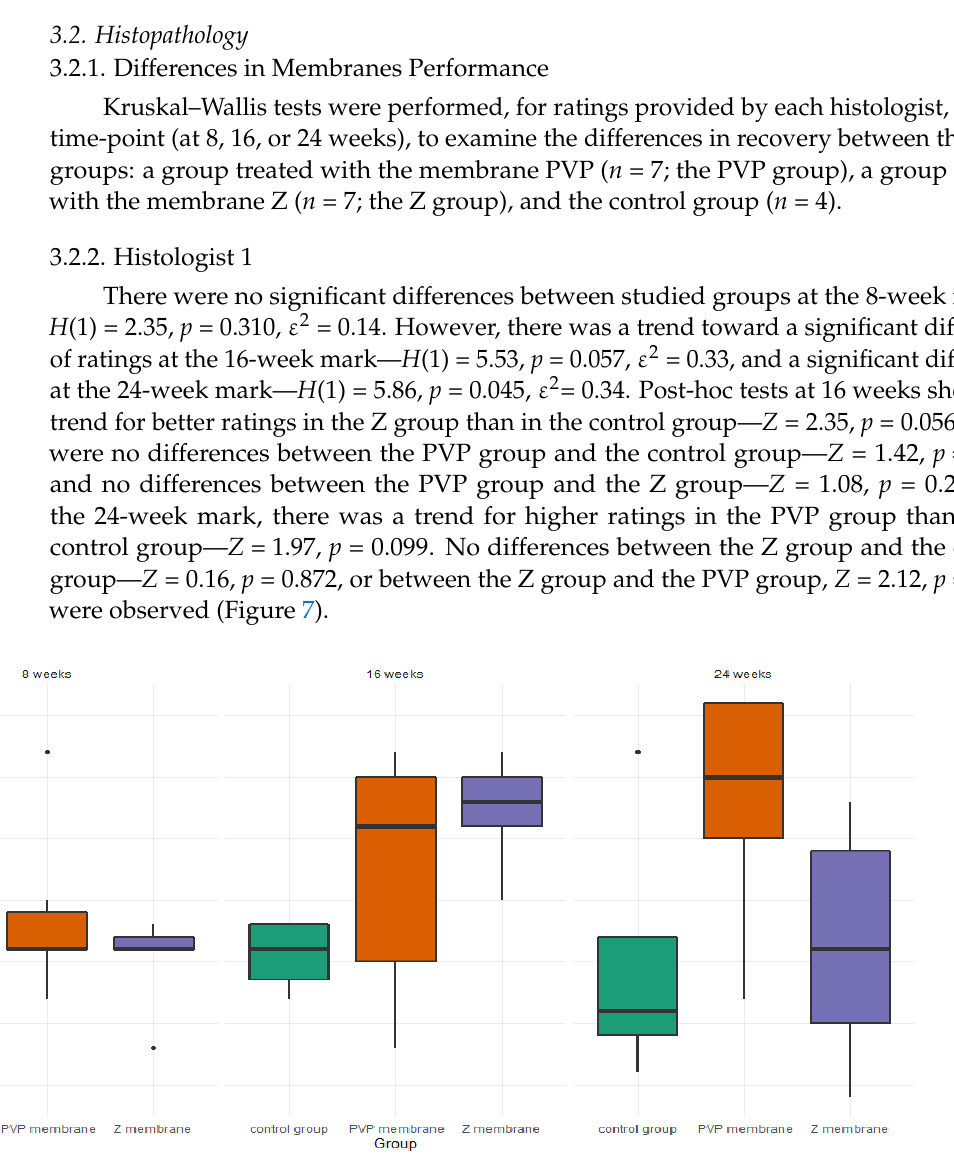
Figure 8. Boxplot of histologist 2 ratings, in the three studied groups, at three time points.